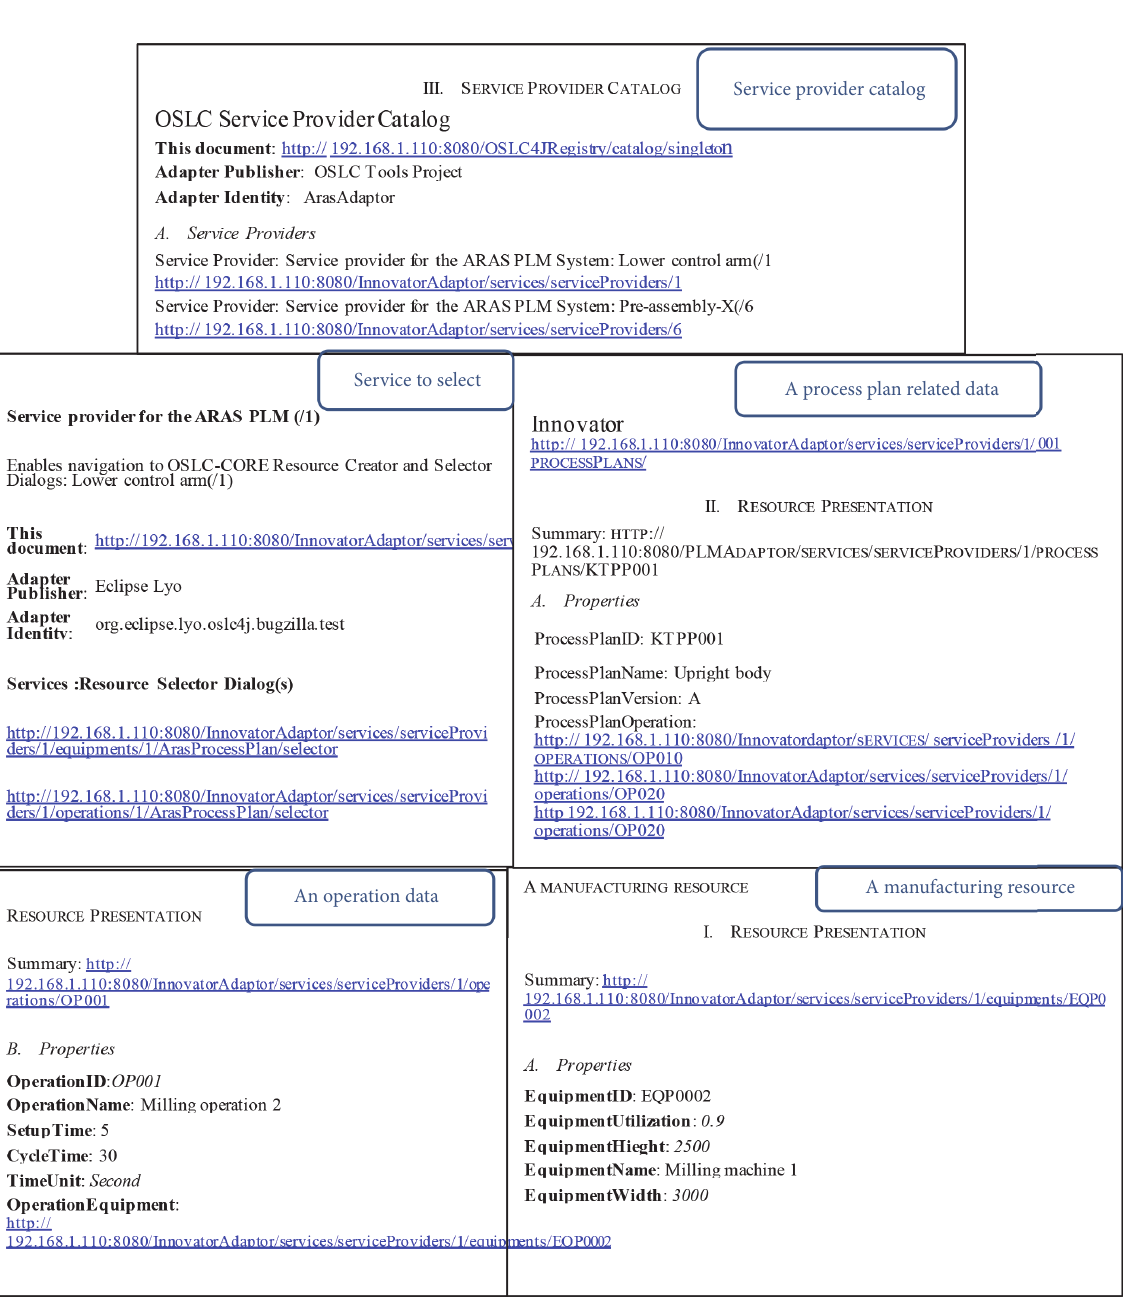
Figure 14: OSLC core services of Innovator for process plan related